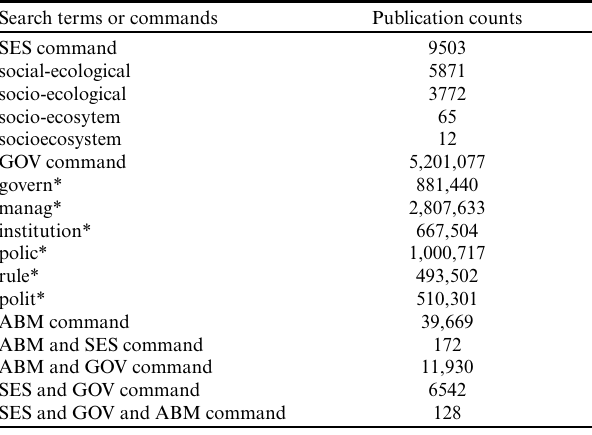
Table 1 . Number of peer-reviewed publications according to Scopus search terms (on 19/10/2020). As per normal Boolean search rules, the specific phrase within quotation marks will be found and an asterisk will highlight any word that begins with the root/stem of the word truncated by the asterisk. Social-ecological systems (SES) search command refers to: (“social-ecological”) OR (“socio-ecological”) OR (“socio-ecosystem”) OR (“socioecosystem”). The agent-based model (ABM) search command refers to: (“agent-based”) OR (“multi-agent”) OR abm OR (“agent based”) OR (“multi agent”). The governance (GOV) search command refers to: (govern* OR manag* OR institution* OR polic* OR rule* OR